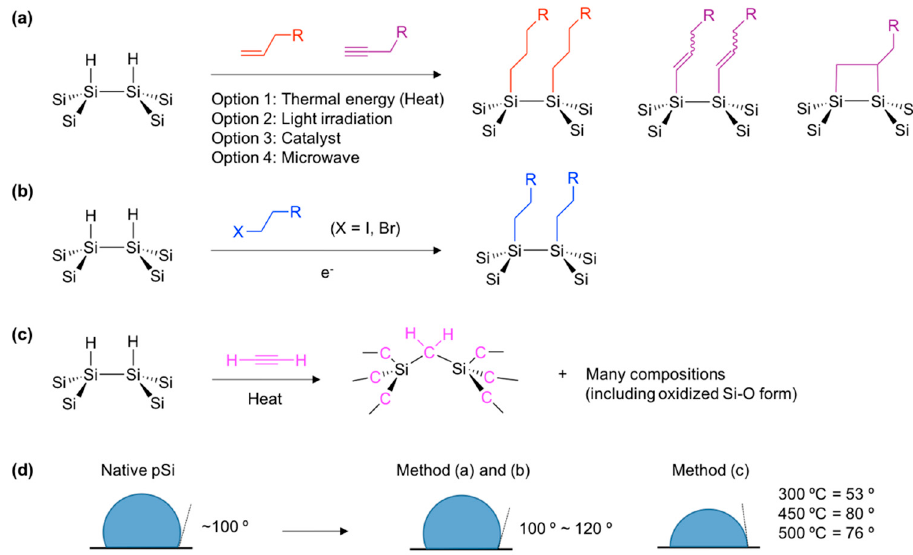
Figure 2. Surface chemistry for native porous silicon (pSi, Si–H). ( a ) Hydrosilylation with unsaturated carbon containing reagents. ( b ) Electrochemical grafting with halide containing reagents. ( c ) Carbonization with acetylene. ( d ) Water contact angle of native pSi and its surface chemistry product. R = simple aliphatic chain, functional group containing aliphatic chain.